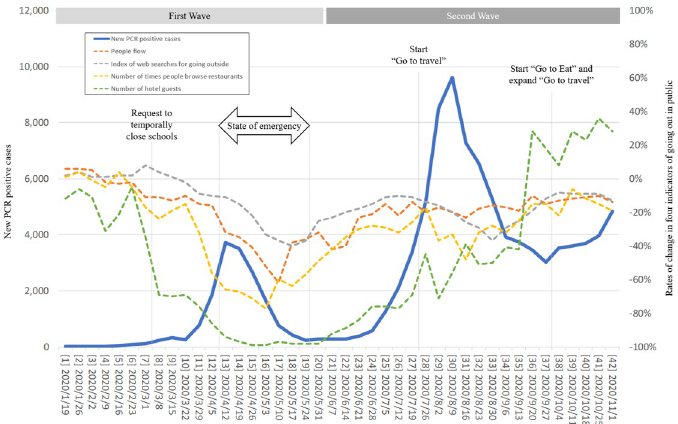
Fig 1. Time trend of new PCR positive cases, four indicators related to going out in public, and representative policies. The number before each date on the x-axis is the consecutive number of weeks, with Week 1 being January